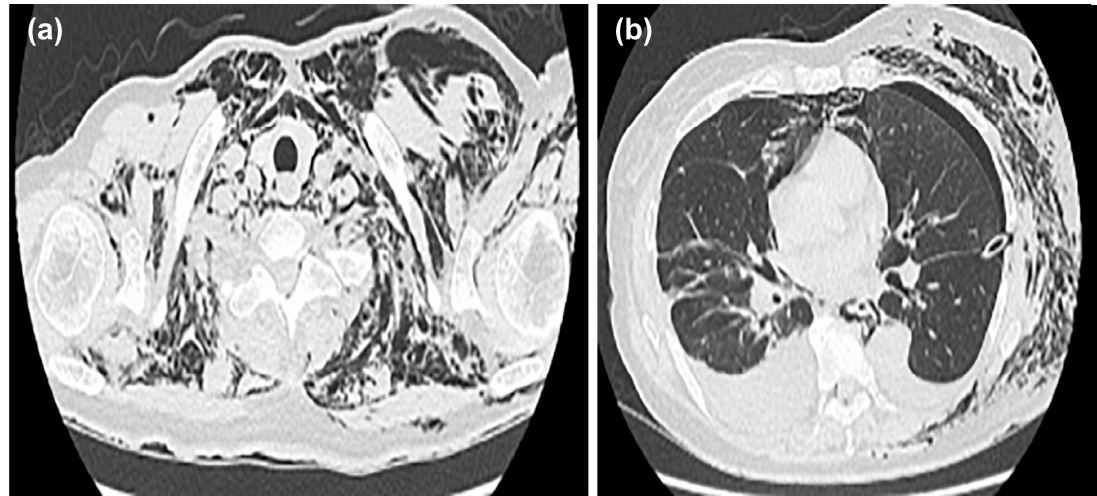
Figure 3. Mediastinal emphysema was observed in the anterior mediastinum, and subcutaneous emphysema was predominant on the left side of the chest ( a ). A drain was inserted between the lobes in the left thoracic cavity ( b ).